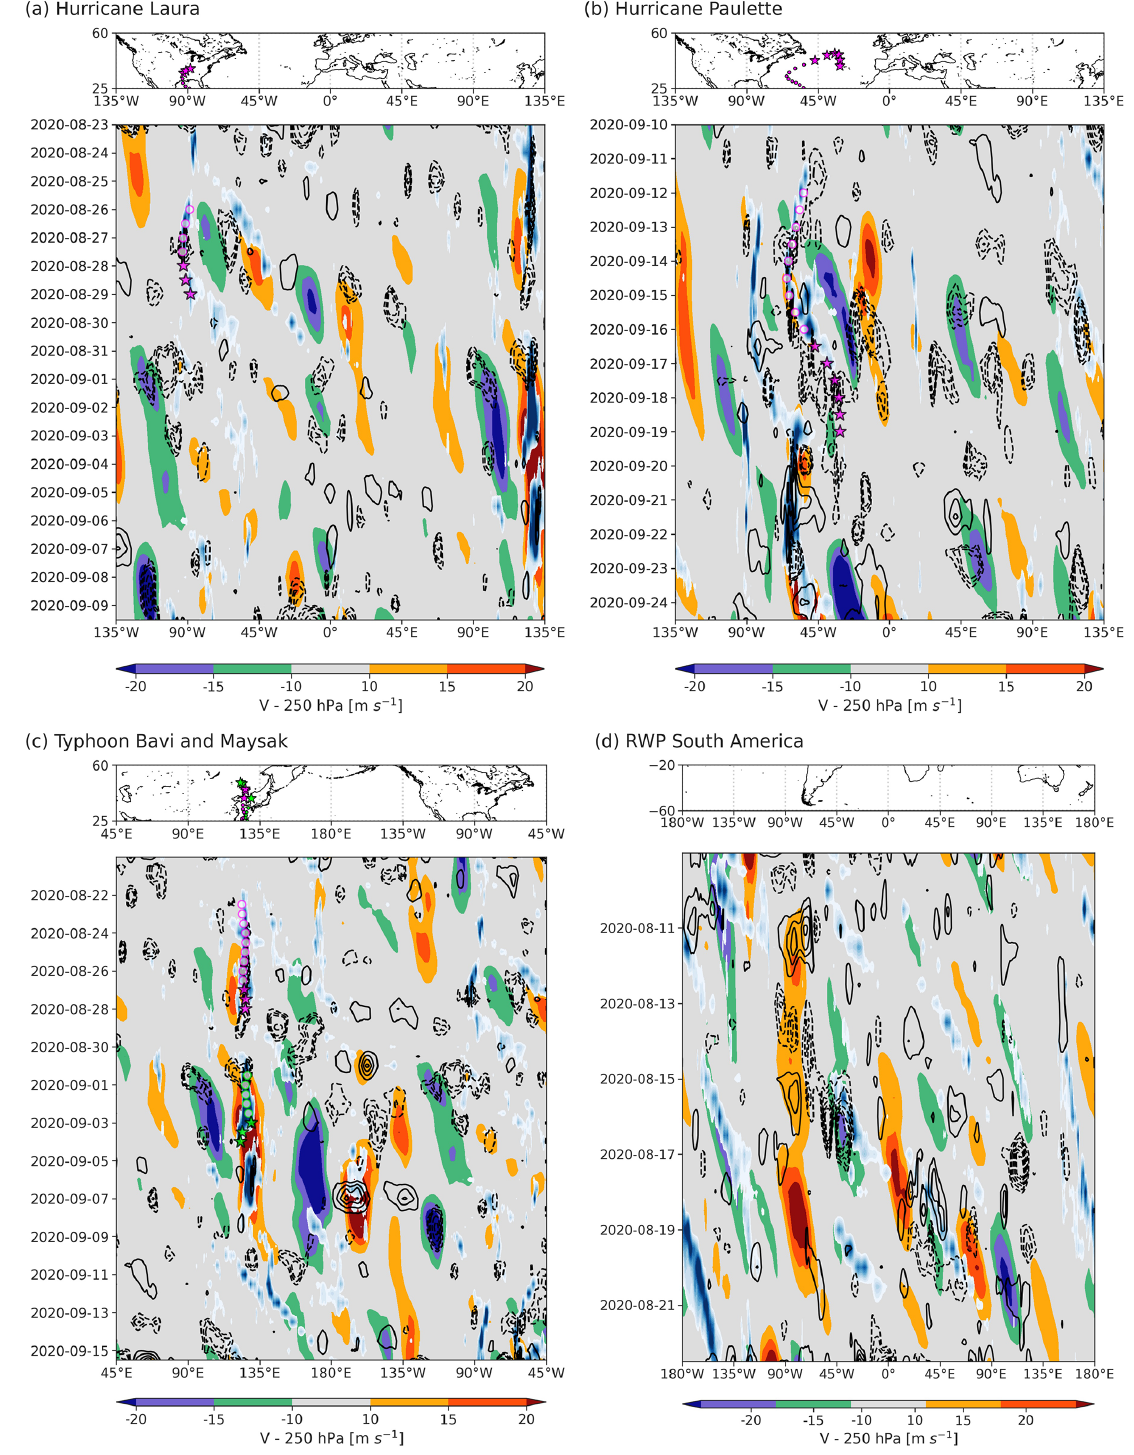
Figure 8. Same as Fig. 5 for the ET event of (a) Hurricane Laura, (b) Hurricane Paulette, and (c) Typhoon Bavi and Typhoon Maysak and (d) an RWP development around the cyclogenesis region over South